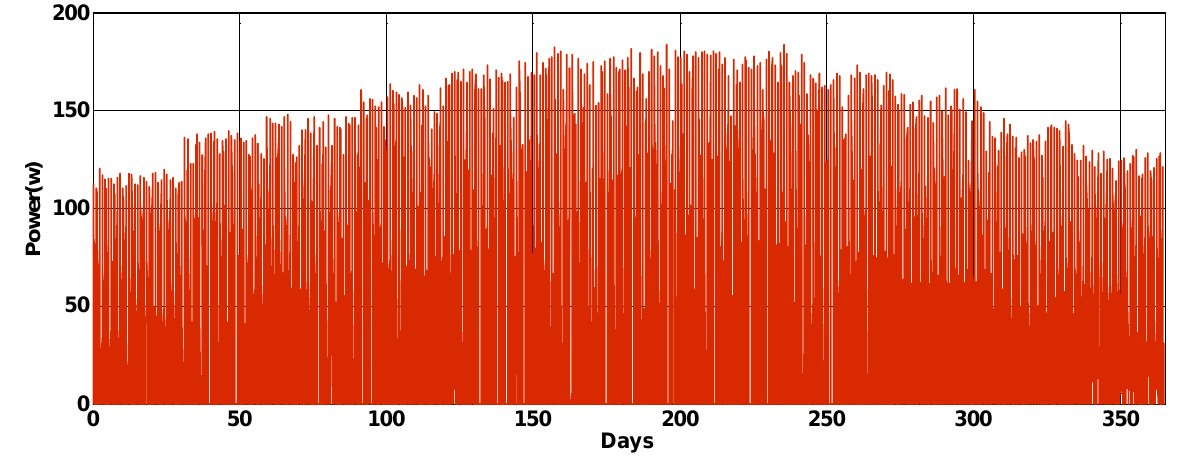
Figure 10. Power of the PV panels (w).